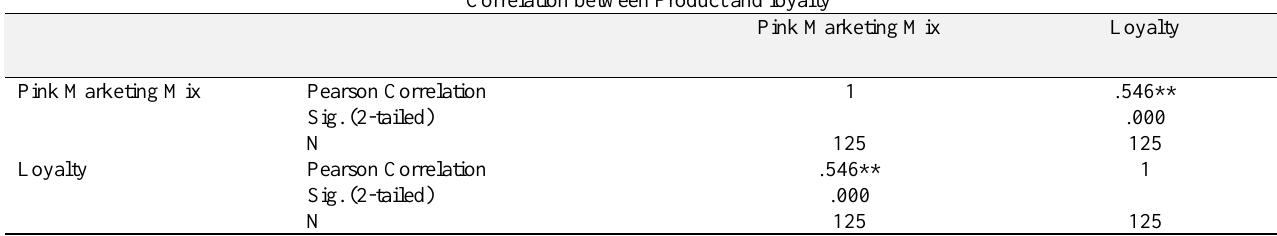
Correlation between Product and loyalty Pink Marketing Mix Loyalty